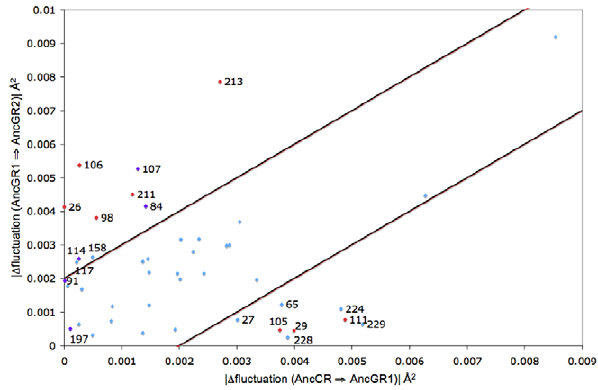
Figure 3. The change in fluctuation along the most collective mode between AncCR, AncGR1 and AncGR2. The X, Y, Z, and Y27R mutation groups necessary to alter function toward cortisol binding specificity are noted in red, and those permissive W mutations necessary to reverse function and recover promiscuous binding are noted in purple. A cutoff of 6 0.002 A˚ 2 is applied to differentiate mutations critical to altering dynamics as also used in Fig. 4. The upper left region of the graph indicates mutations that most alter dynamics when comparing the function-altering mutation from AncGR1 (binding promiscuity) to AncGR2 (binding specificity to cortisol) whereas the lower right region of the plot indicates mutations that most alter dynamics when comparing AncCR and AncGR1, which do not diverge functionally.